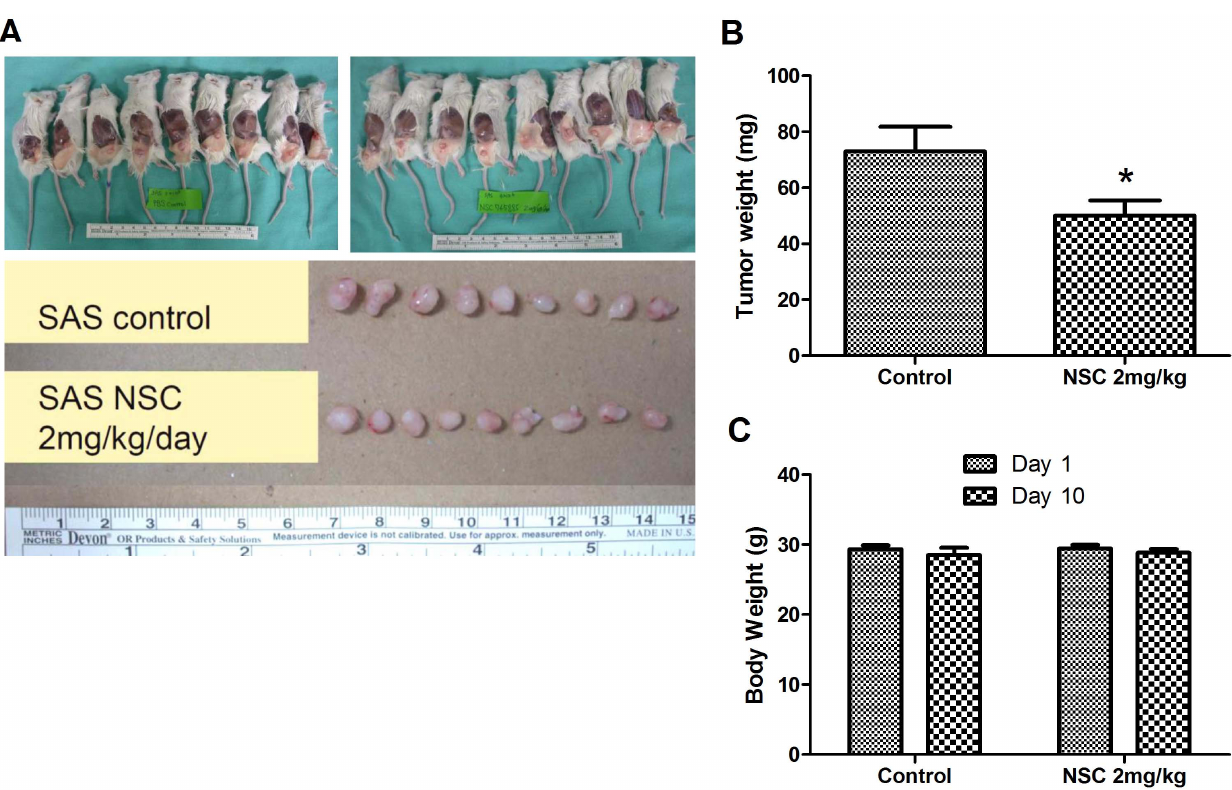
Figure 6. NSC745885 treatment inhibited SAS cell growth in vivo. (A) The cancer cell implanted NOD/SCID mice were administered with NSC745885 (2 mg/kg/d). Engrafted tumors were isolated on Day 10 after drug administration. NSC745885 treatment significantly reduced tumor size when compared with the vehicle control. (B) The average tumor weight was compared between the NSC745885-treated and PBS-treated tumor- bearing mice on Day 10 (n = 9; *, P , 0.01). (C) The body weight of the experimental mice did not significantly decrease with NSC745885 treatment compared with the PBS treated controls.